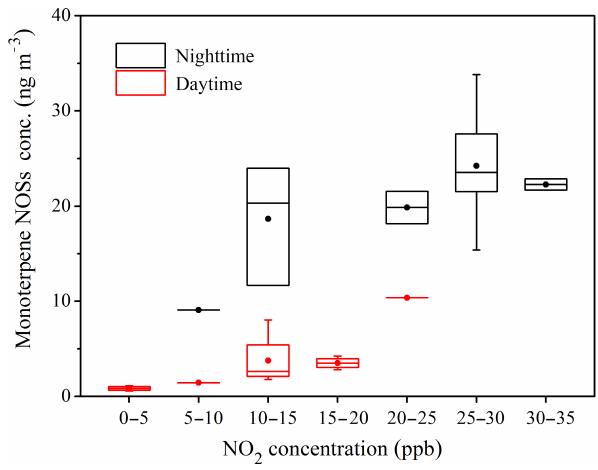
Figure 6. The concentrations of monoterpene NOSs (C 10 H 16 NO 7 S − ) as a function of NO 2 concentration bins (ppb) during daytime and nighttime. The closed circles represent the mean values and whiskers represent 25 and 75 percentiles.